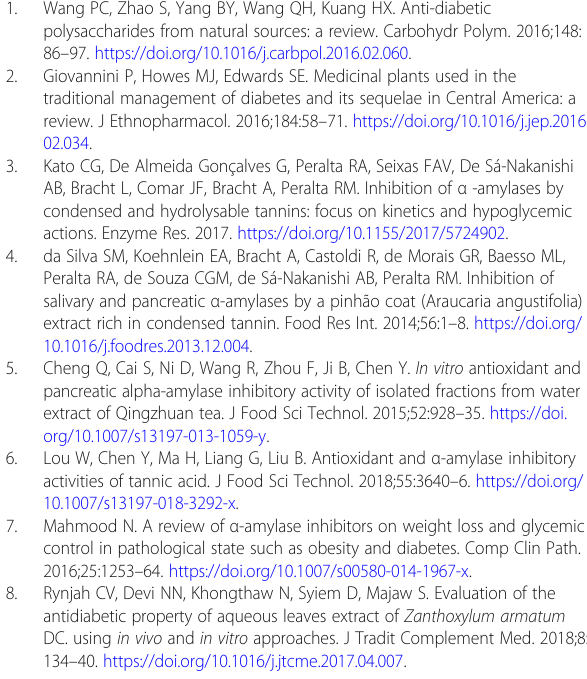
Additional file 1: Table S1 . Software scores found on docking ligands to porcine pancreatic alpha